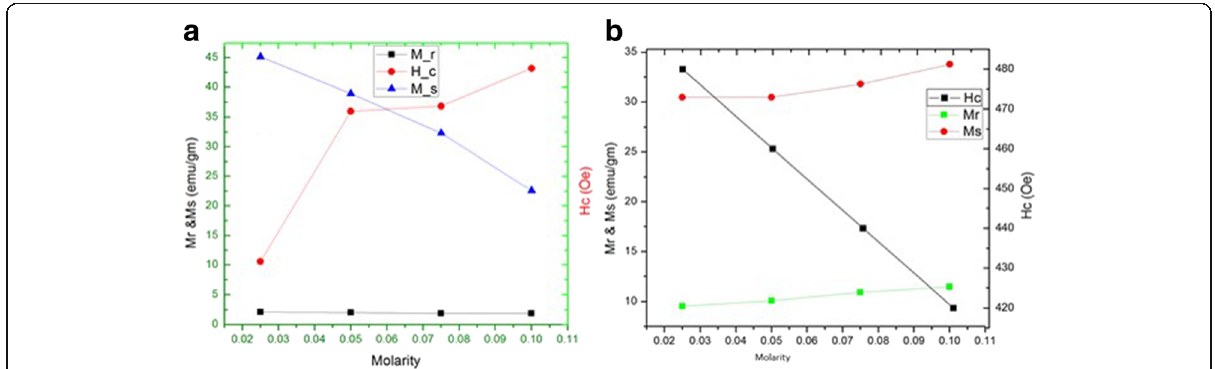
Fig. 4 a , b Variation of Mr, Ms and Hc as a function of molarity for different samples at 300K and 5K